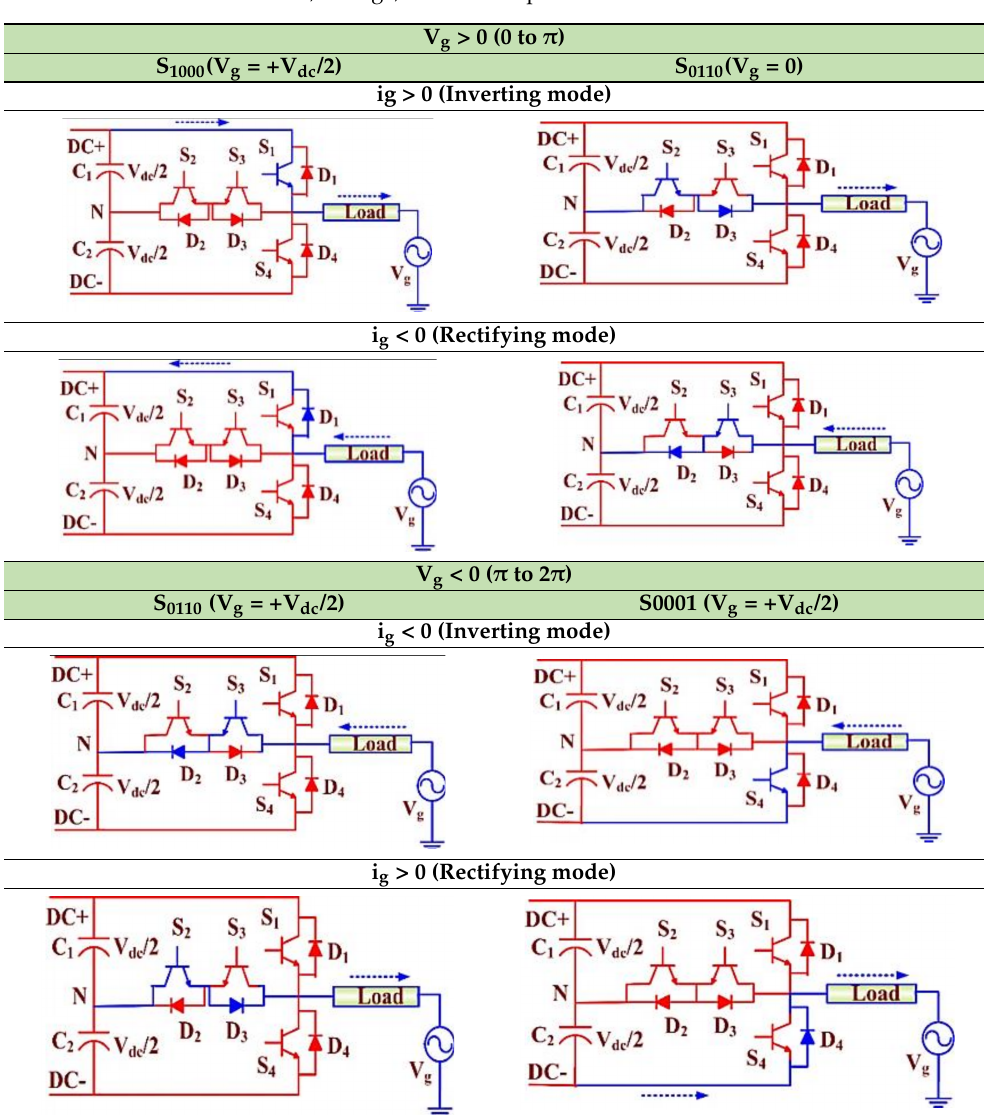
Table 1. Commutation interval, voltage, and current path for transformer-less